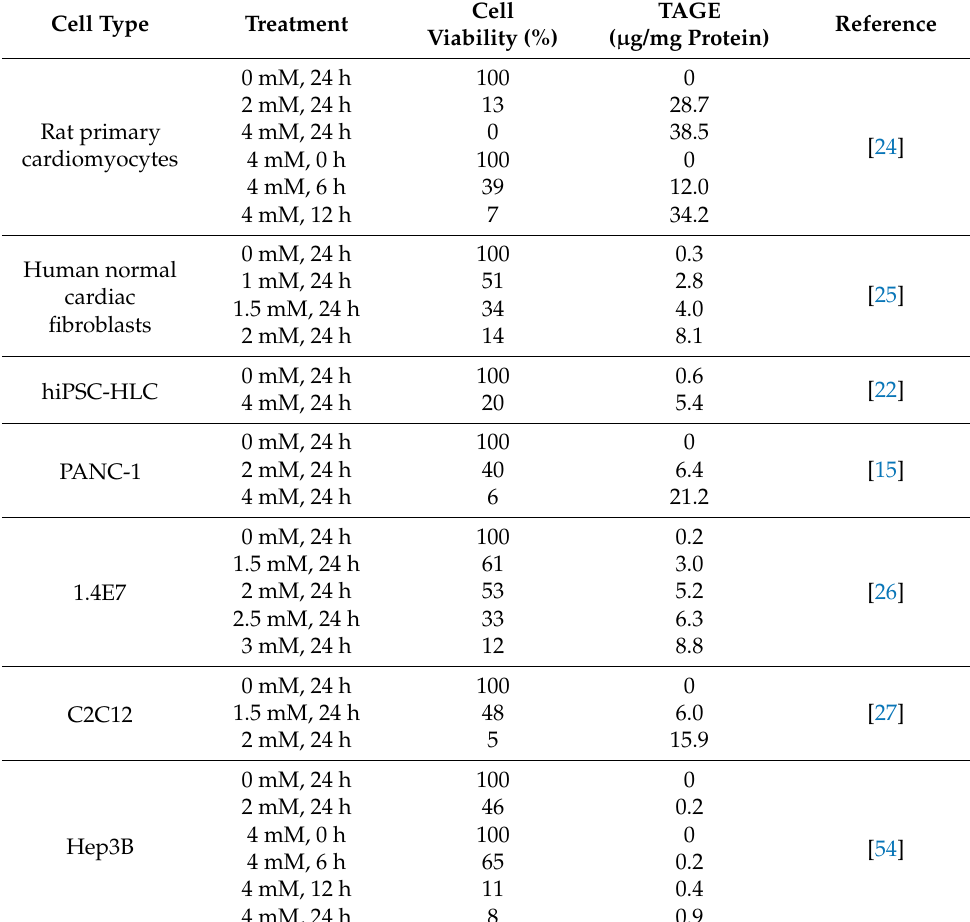
Table 5. Competition between cell viability and intracellular